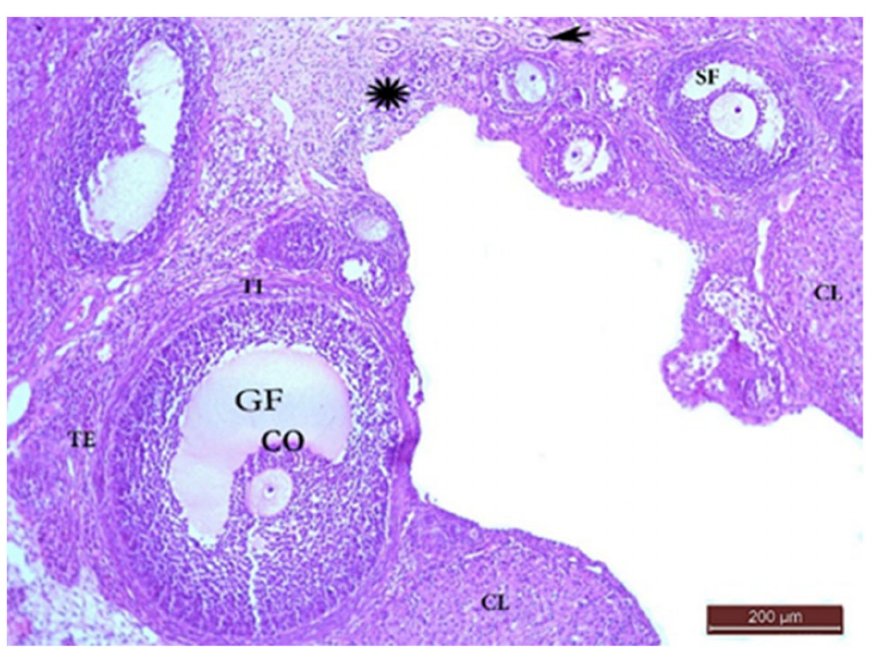
Figure 1. H&E × 100 Photomicrograph from G I ovary. Ovarian section from G I rat at x100 magnification showing different stages of normal follicular development with little stroma in between. Mature Graafian follicle (GF) containing cumulus oophorus (CO) and surrounded with theca interna (TI) and theca externa (TE) layers. Multiple primordial follicles (*), primary follicles (arrow), and secondary follicle (SF) with corpora lutea (CL) had large faintly stained acidophilic